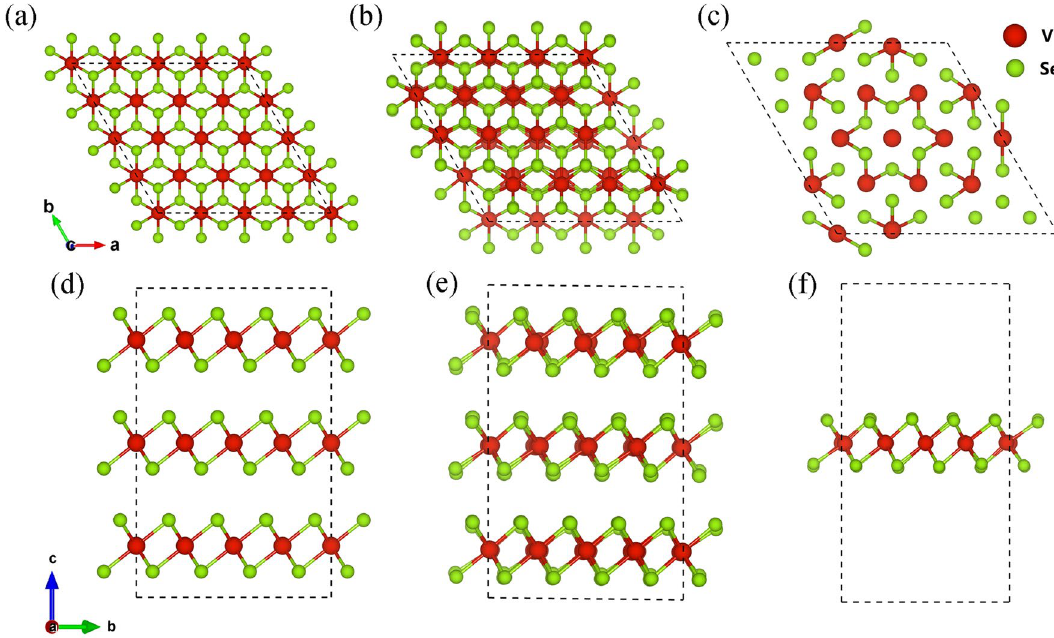
Figure 1. Top view and side view of the crystal structure of bulk 1T-VSe 2 and its 3D/2D CDW orders. Top view ( a ) and side view ( d ) of 4 × 4 × 3 supercell of normal state 1T-VSe 2 . Top view ( b ) and side view ( e ) of 4a × 4a ×